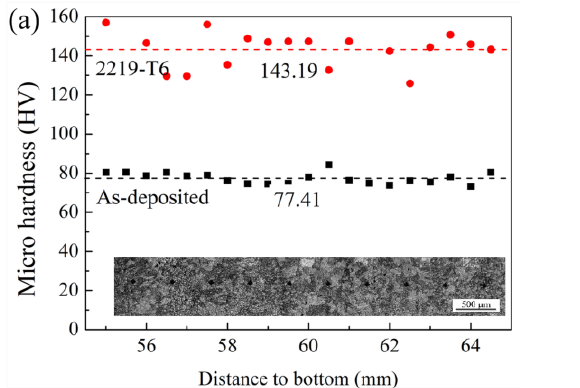
Figure 2. Main effect plots for S/N ratio and means for ( a , b ) UTS, ( c , d ) YS, and ( e , f ) elongation.